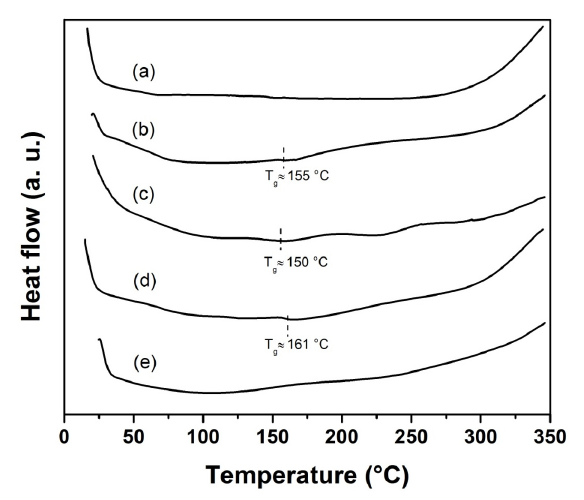
Figure 6. DSC thermograms of SR ( a ), SR-g-(NVCL-co-NVIM) 75% graft ( b ), poly(NVCL-co-NVIM) ( c ), SR-g-NVIM 90% graft ( d ), and SR-g-NVCL 29% graft ( e